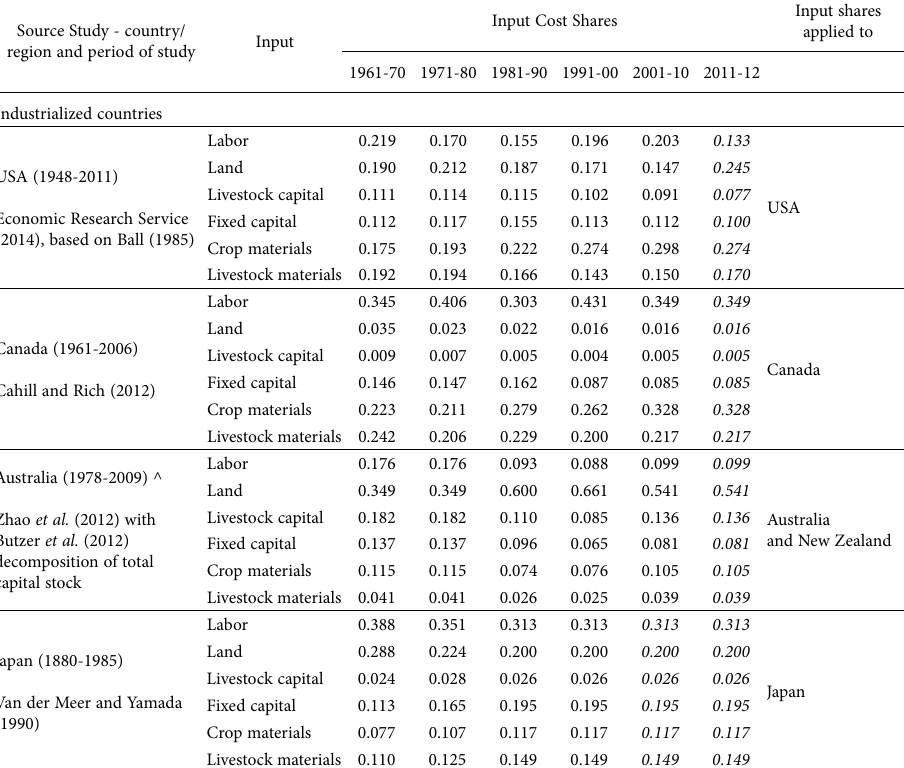
Table A2. Agricultural Input Cost